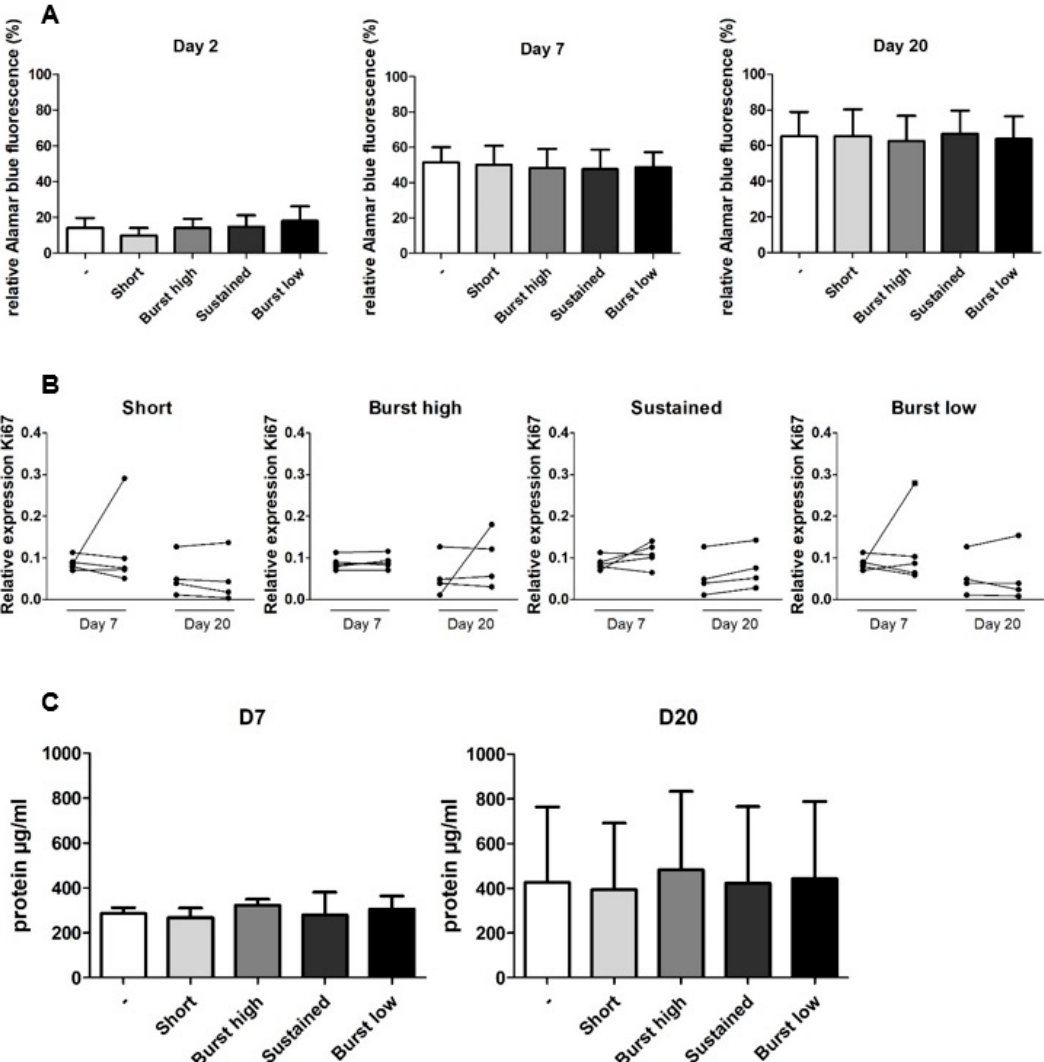
Figure 3. E ff ect of vitamin D 3 on proliferation and protein content of hASCs. hASCs were subjected to the various vitD 3 treatment modalities and Alamar blue was measured at Days 2, 7, and 20; the gene expression of Ki67 was measured at Days 7 and 20; and total protein content was measured at Days 7 and 20. ( A ) VitD 3 treatment did not a ff ect Alamar blue measurement between any of the groups, at any time point measured. ( B ) Gene expression of proliferation marker Ki67 did not significantly di ff er between vitD 3 -treated and control groups. Gene expression in controls (left) and vitD 3 -treated cultures (right) of the same donor are connected by a line. ( C ) Total protein content was similar between all vitD 3 -treated groups at Day 7, as well as on Day 20. Data represent four or five independent donors (mean + SD). Gene expression data was normalized to HPRT .